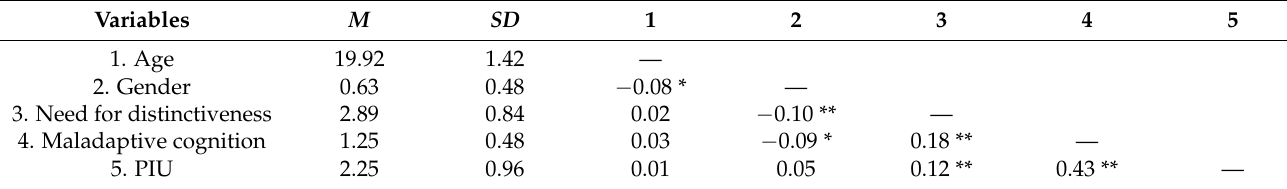
Table 1. Correlation coefficients of the variables.